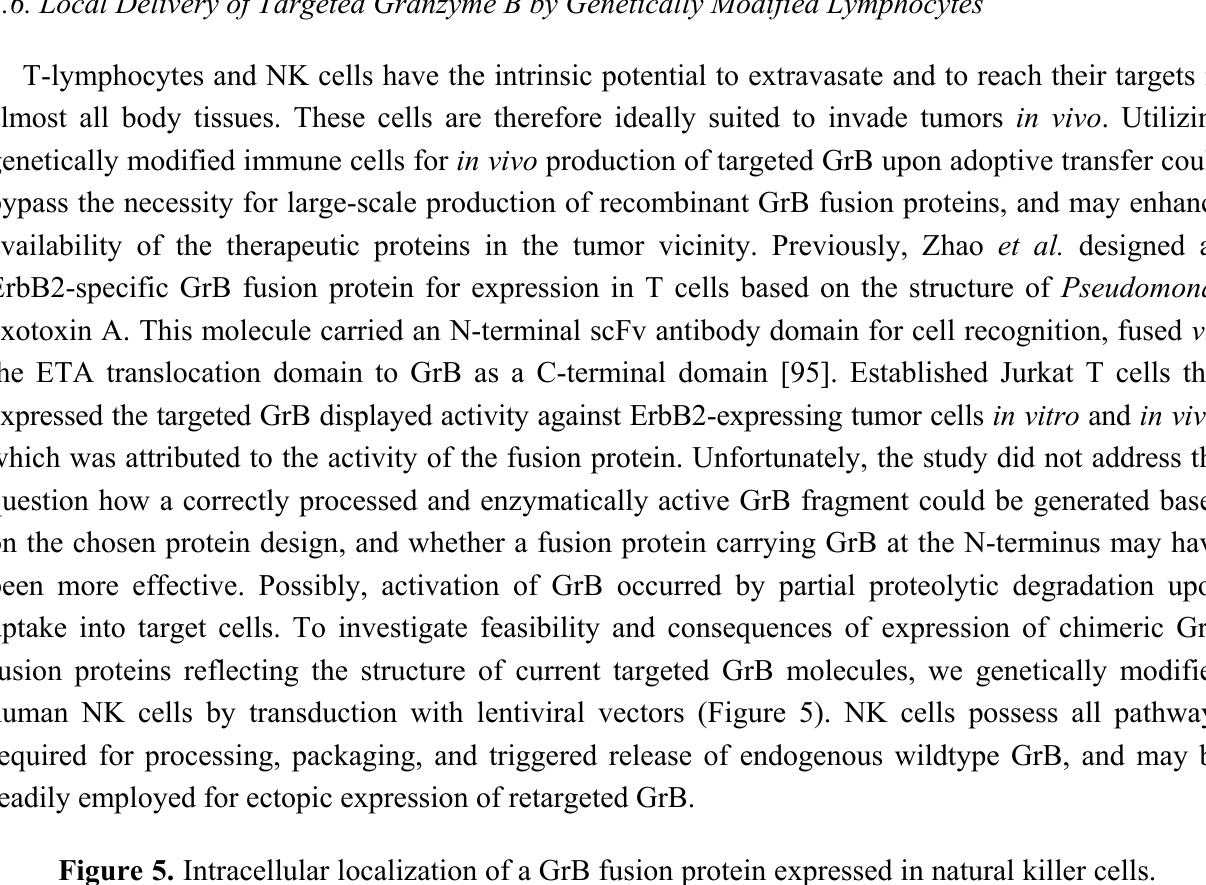
Figure 5. Intracellular localization of a GrB fusion protein expressed in natural killer cells. Established human NKL cells [100] were transduced with a lentiviral vector encoding human pre-pro-GrB genetically fused to enhanced green fluorescent protein (EGFP) (left), or a control vector encoding unfused EGFP (right). Intracellular localization of GrB-EGFP and EGFP proteins was analyzed by confocal laser scanning microscopy (upper